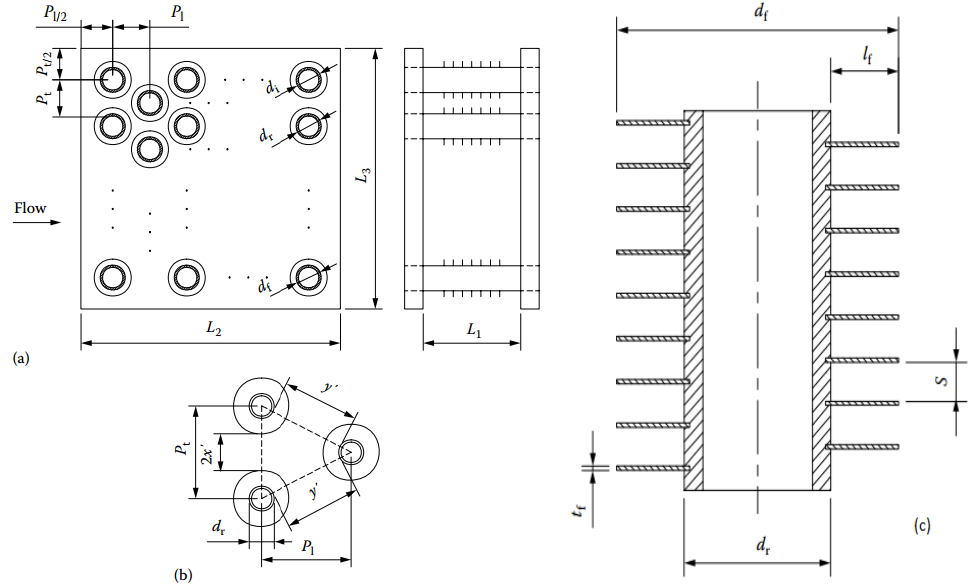
Figure 3. Tube fin details. Individually finned tube staggered arrangment. ( a ) Geometry; ( b ) unit cell and ( c ) tube fin